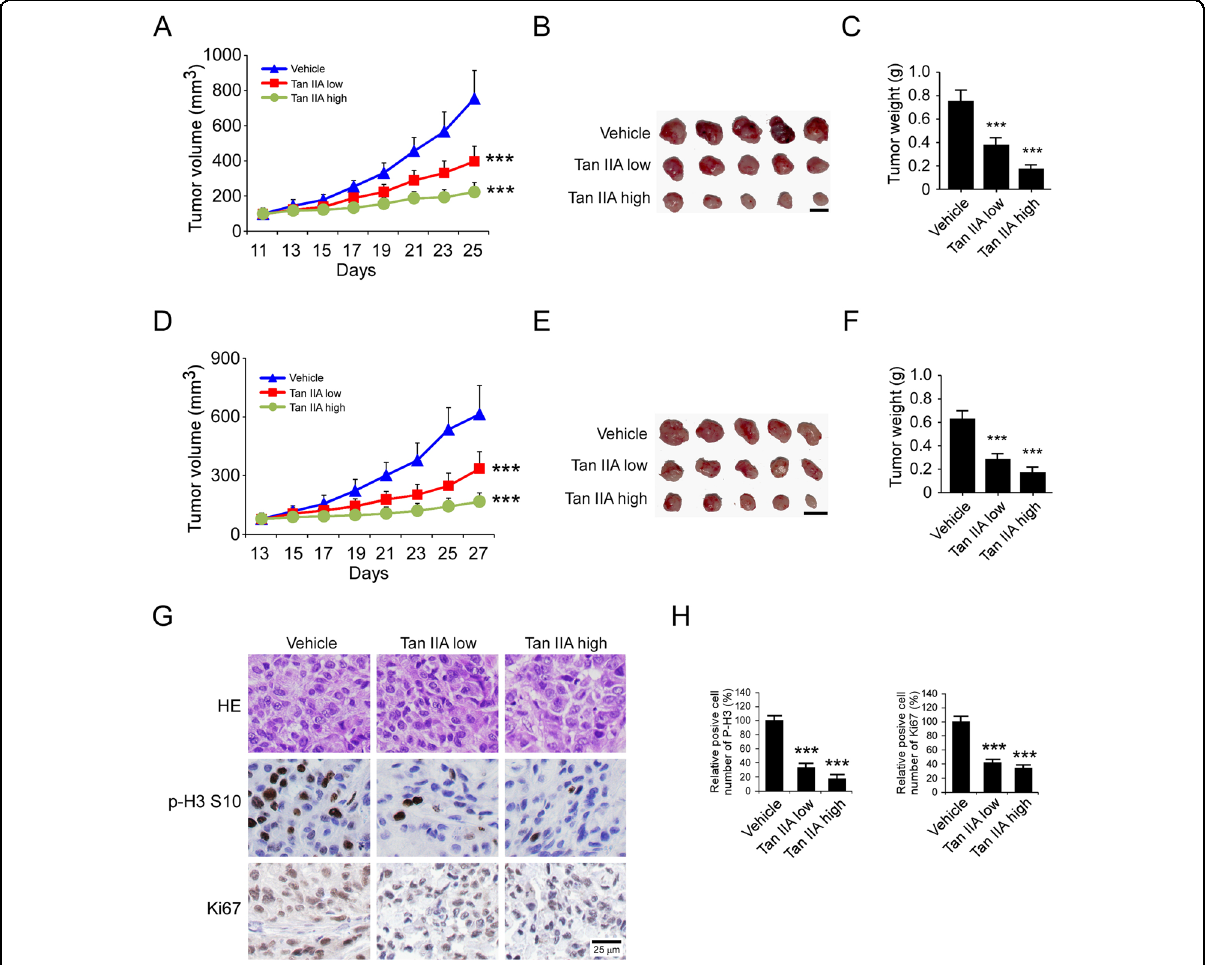
( C ) of CAL27-derived xenograft tumors treated with vehicle or Tan IIA; n = 5 mice per group, one-way ANOVA. *** p < 0.001. D – F The tumor volume ( D ), The image of tumor mass ( E ), and tumor weight ( F ) of SCC25-derived xenograft tumors treated with vehicle or Tan IIA; n = 5 mice per group, one-way ANOVA.*** p < 0.001. For B and E , scale bar, 1 cm. G IHC staining of Ki67 and p-Histone H3 Ser10 in CAL27-derived xenograft tumors with vehicle or Tan IIA treatment. Scale bar, 25 μ m. H Quali fi cation analysis of p-Histone H3 Ser10 and Ki67 in CAL27-derived xenograft tumors with vehicle or Tan IIA treatment; one-way ANOVA, *** p <